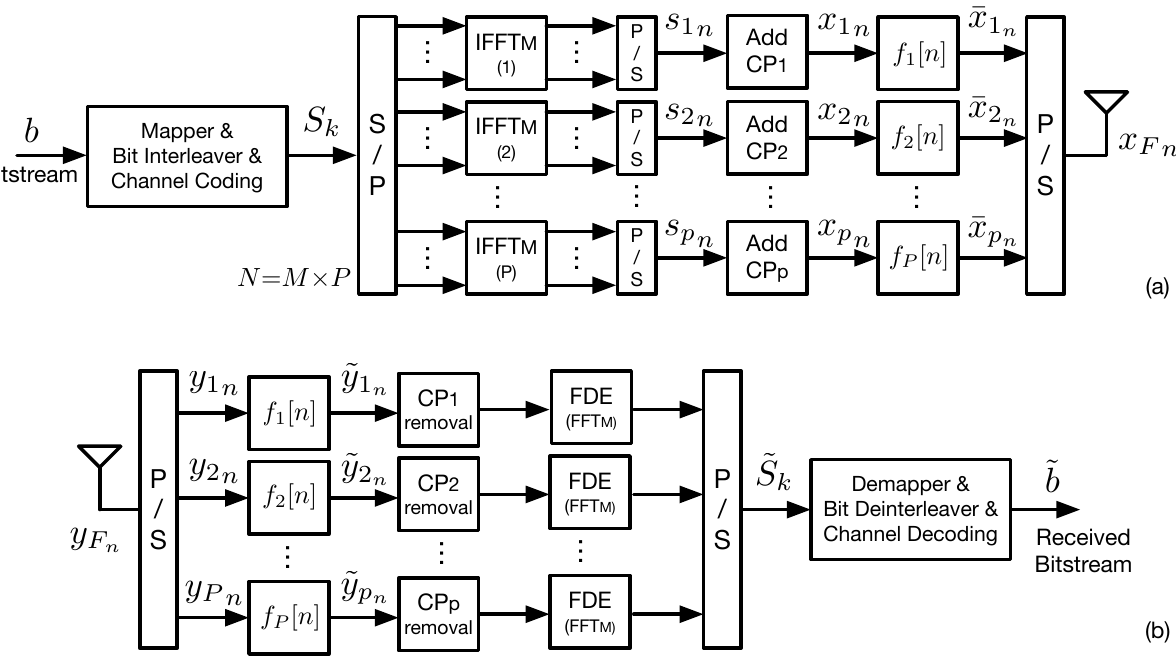
Figure 2. F-OFDM transmitter ( a ) and receiver ( b